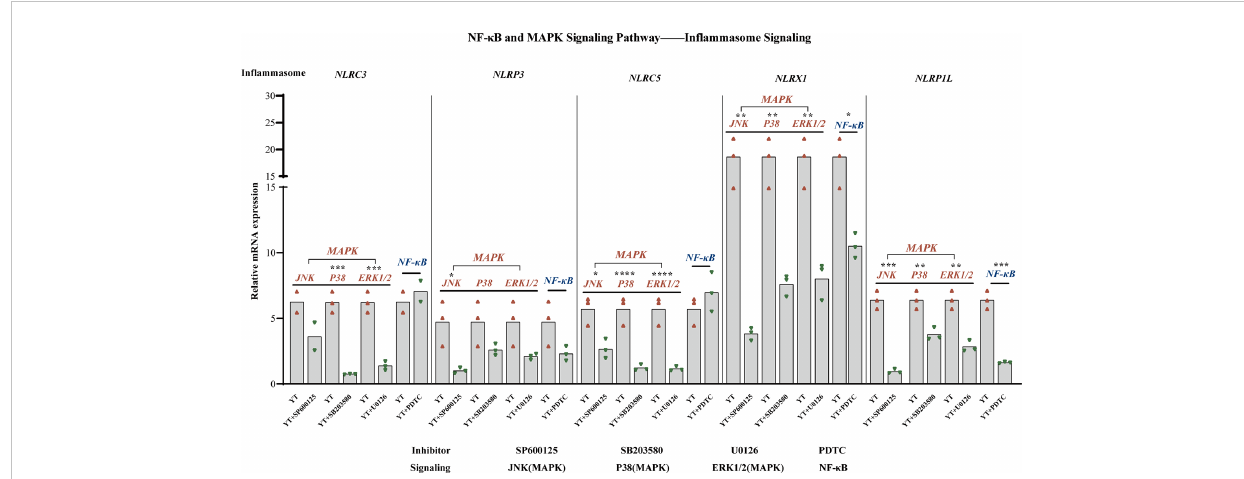
FIGURE 7 MAPK (JNK, P38, and ERK1/2) and NF- k B are involved in NLRs production. NLRX1 expression was suppressed by treatment with SP600125 (not signi fi cant), SB 203580 (P < 0.01), and U0126 (P < 0.01). NLRP3 is regulated positively by SP600125 (P < 0.05), SB 203580 (not signi fi cant), U0126 (not signi fi cant), and NF- k B (not signi fi cant). NLRC5 expression was suppressed under the treatment of SP600125 (not signi fi cant), SB 203580 (P < 0.01), and U0126 (P < 0.01). NLRX1 activity is attenuated in consistent with the decreased of JNK (P < 0.01), P38 (P < 0.01), ERK1/2 (P < 0.01), and NF- k B (P < 0.05). NLRP1L activity is attenuated consistent with the decreased of JNK (P < 0.01), P38 (P < 0.01), ERK1/2 (P < 0.01), and NF- k B (P < 0.01). The mRNA expression levels of NLRs were measured using qRT-PCR and calculated in relation to the expression level of b -actin. Symbols indicate comparisons with the control group; *P < 0.05, **P < 0.01, ***P < 0.001 and ****P <